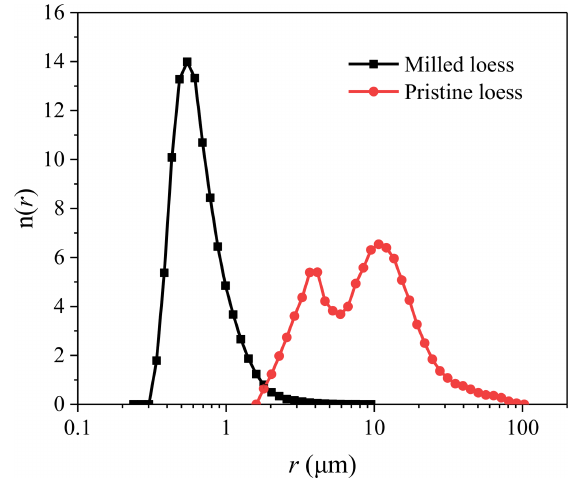
Figure 1. Normalized number size distributions n(r) of pristine loess and milled loess. Radius r is plotted in logarithmic scale, and error bars are small and covered by